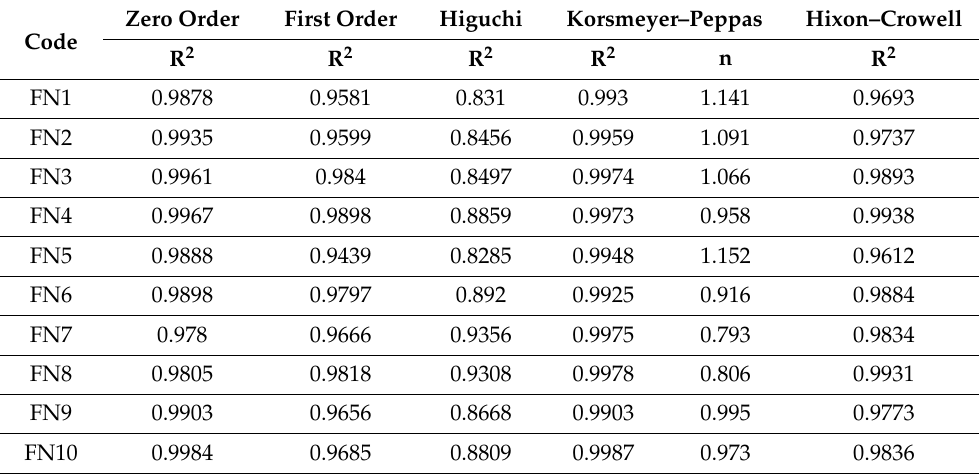
Figure 2. The release of FLZ from prepared novasomes containing different ratios of FFAs and SAAs. Table 2. Release kinetics by different